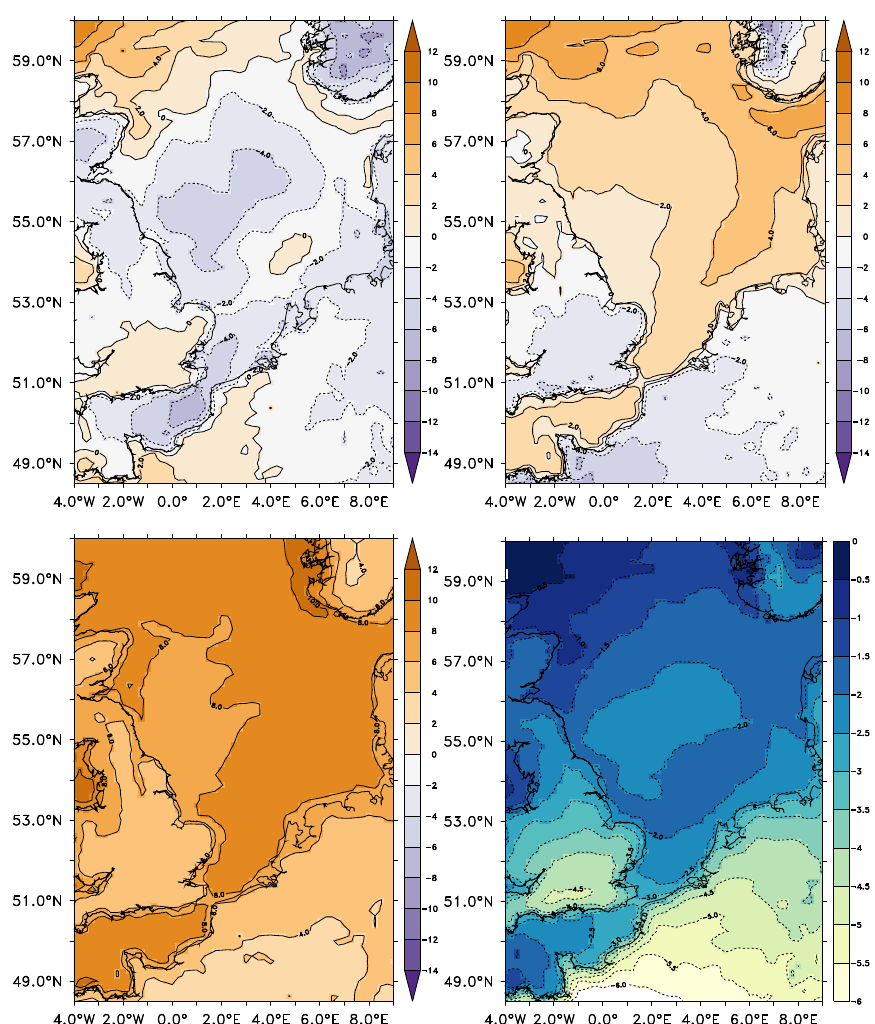
Figure 9. Climatological annual mean changes in latent heat flux (W/m 2 ) ( upper left ), sensible heat flux (W/m 2 ) ( upper right ), longwave radiation (W/m 2 ) ( lower left ), and relative humidity (%) ( lower right ) of the RCA4-NEMO RCP8.5 ensemble mean between periods P0 and